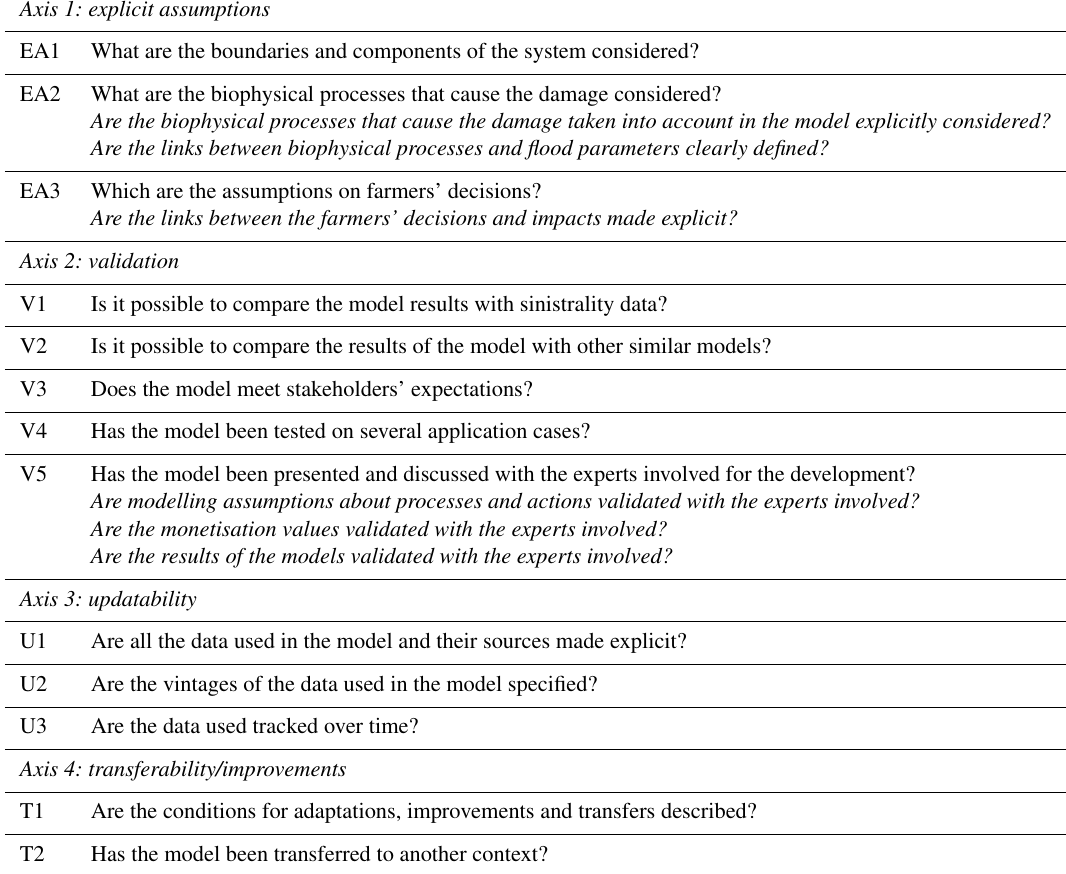
Table 1. Methodological framework for the development of process-based flood damage models. Axis 1: explicit